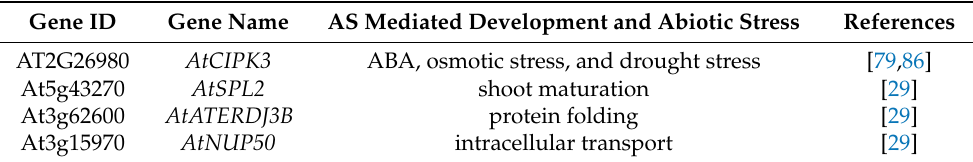
Table 4. Summary of the fundamental studies on AS in ABA-mediated plant development and abiotic stress